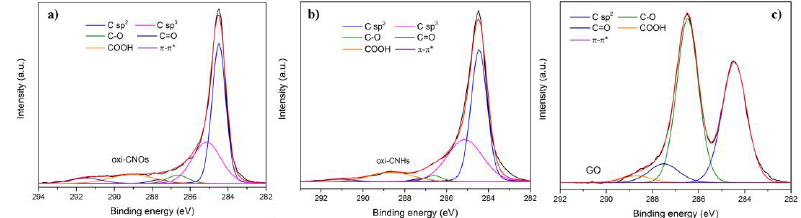
Figure 2. XPS spectra of the C1s region of ( a ) oxi-CNOs; ( b ) oxi-CNHs and ( c ) GO, including peak-fitting analysis.